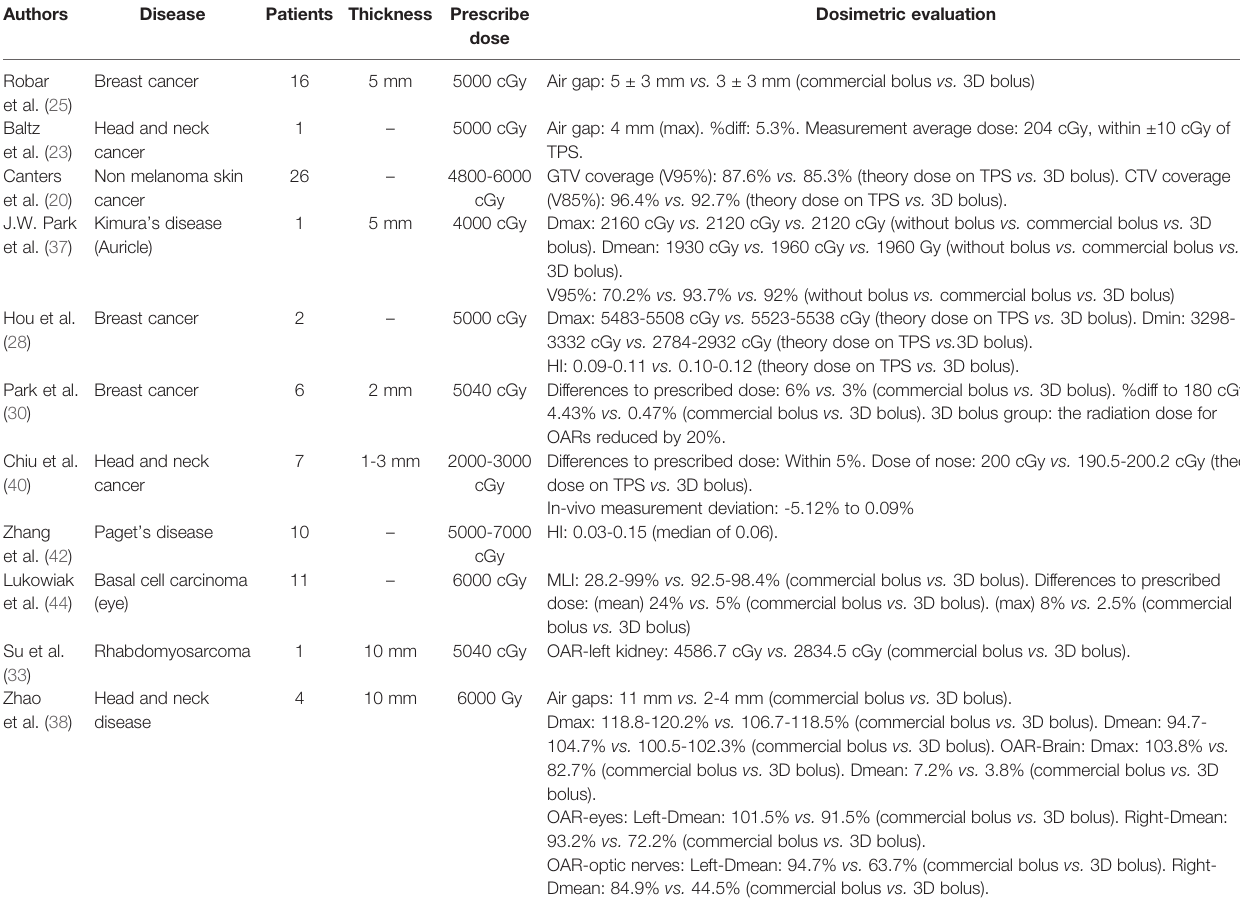
TABLE 3 | Clinical dosimetric evaluation of the 3D-printed bolus. Authors